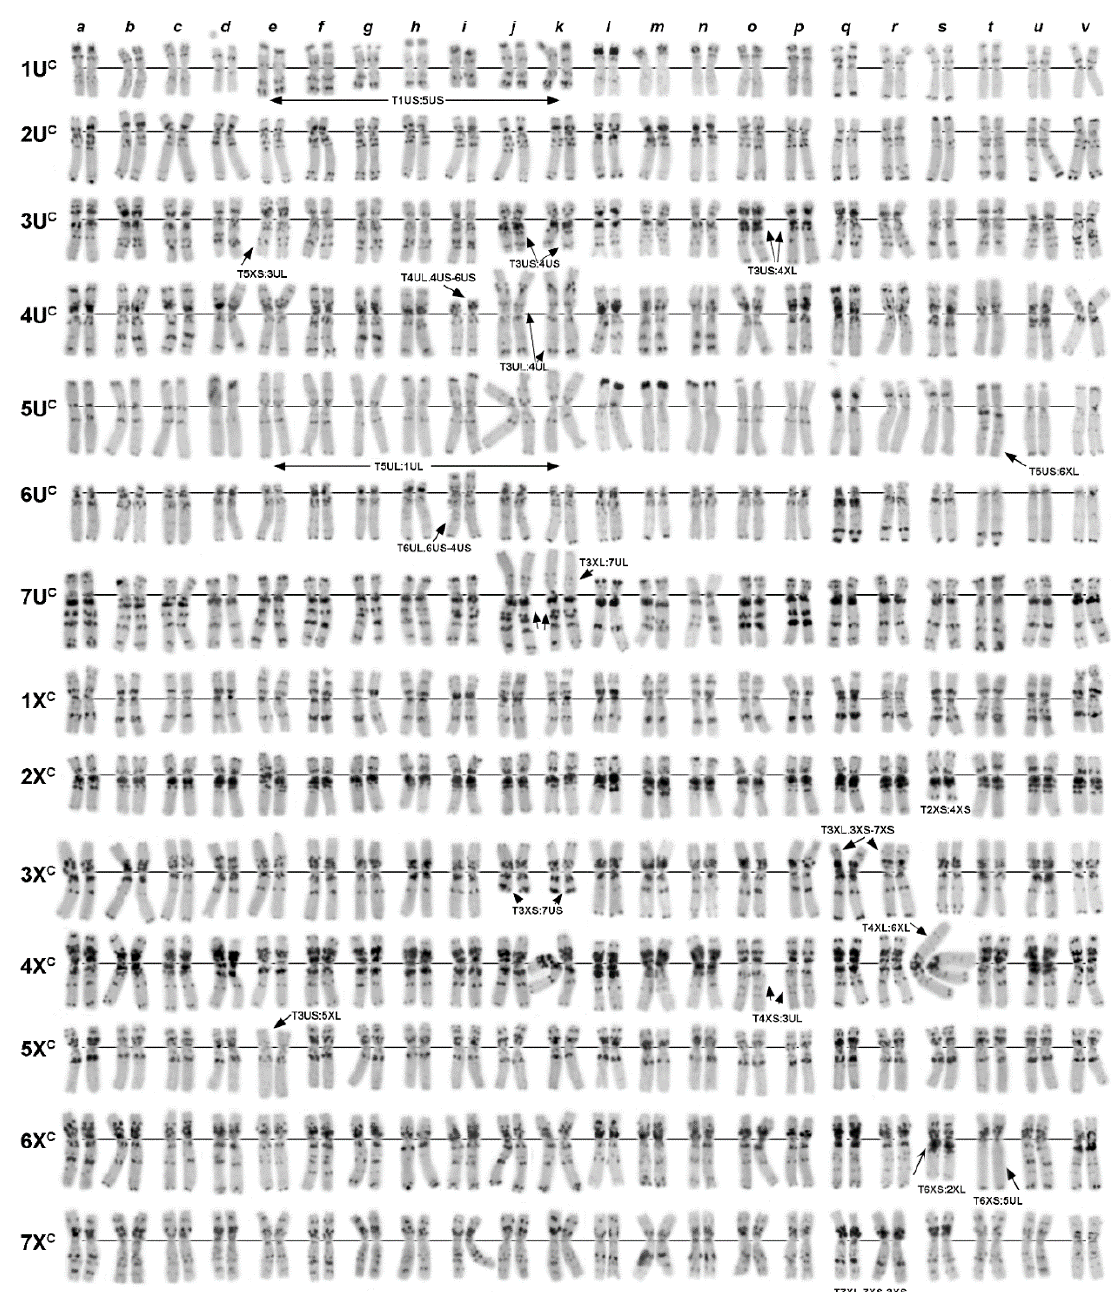
Figure 6. Polymorphisms of the C-banding patterns of Transcaucasian ( a – r ) and Iranian ( s – v ) accessions of Ae. columnaris: ( a )—K − 2344; ( b )—K − 4224a; ( c )—K − 4229; ( d )—K − 1512; ( e )—K–4228; ( f )—K − 1178; ( g )—K − 1495; ( h )—PI 499258; ( i )—K − 1193; ( j )—K − 4225; ( k )—K − 4551; ( l )—N − 1; ( m )—N − 2; ( n )—N − 3; ( o )—K − 4224b; ( p )—K − 564; ( q )—PI 276457; ( r )—PI 574457; ( s )—K − 4240; ( t )—K − 4418; ( u )—IG 48818; ( v )—K − 4413. 1U c –7X c —chromosomes; translocated chromosomes are indicated with arrows and designated, respectively.